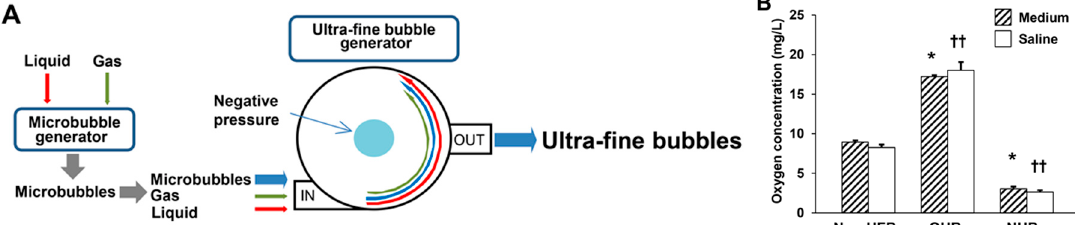
Figure 7. Preparation of UFBs diluted in medium and saline. ( A ) The ultra-fine bubble aerator. Fine microbubbles of gas (oxygen or nitrogen) were generated after brief sonication. Then UFBs were generated using a gas–liquid (oxygen or nitrogen; culture medium or saline) mixing system with hydrodynamic function. In this apparatus, gas was supplied at 0.1 MPa and 0.7 L/min into microbubble water for 30 min. The high-speed centrifugal force caused by the circulation separates the microbubbles into UFBs by the strong shearing force in the dispersed water; ( B ) the dissolved oxygen concentration of OUBs and NUBs diluted in medium or saline (OUB or NUB-saturated liquid, that is, OUB or NUB concentration 100%) was measured at 30 min after generation by Winkler’s method. The OUB data were analyzed by one-way ANOVA followed by Dunnett test. Graphs show mean ± SD. * p < 0.05 vs. non-UFB medium, †† p < 0.01 vs. non-UFB saline. UFBs: ultra-fine bubbles, OUBs: oxygen ultra-fine bubbles, and NUBs: nitrogen ultra-fine